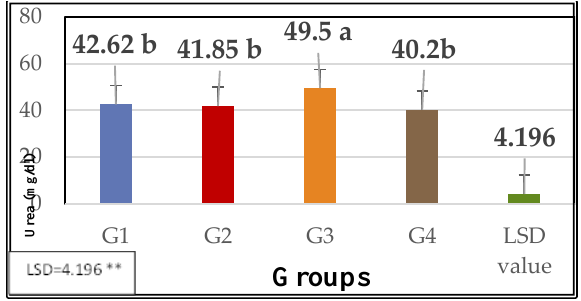
Figure, 4: Effect of Betaine intubation on Urea (mg/dl) concentration in experimental group.